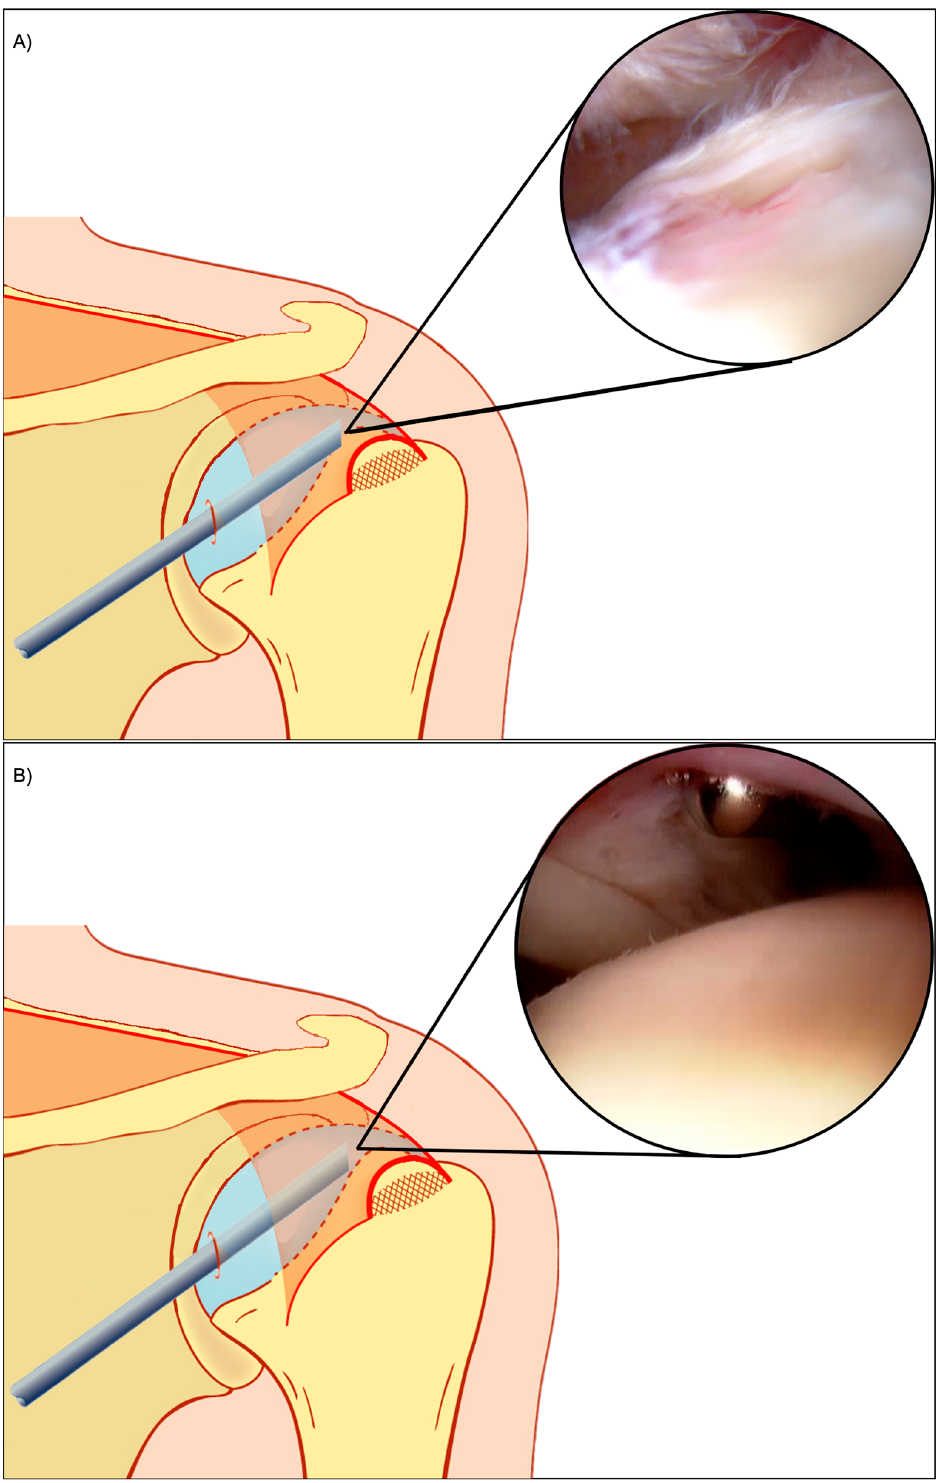
Figure 1. ( A ) Arthroscopic rotator cuff repair visualised from the bursal side. ( B ) Arthroscopic rotator cuff repair visualised from the undersurface. Adapted from Wu et al. [20] .